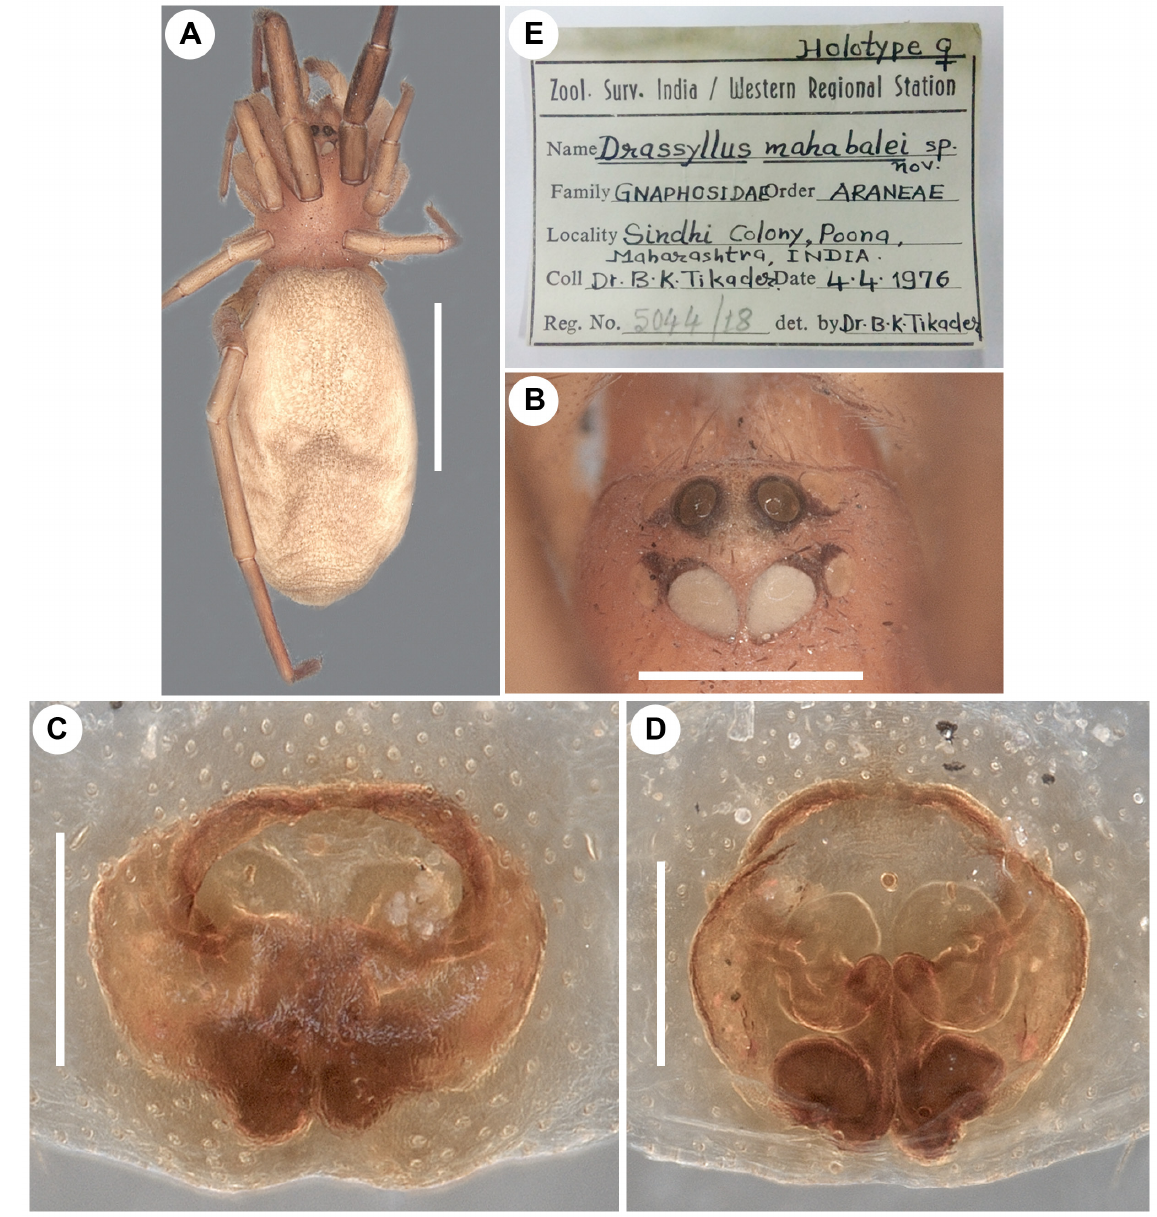
Fig. 3. Cryptodrassus mahabalei (Tikader, 1982) comb. nov., ♀, holotype of Drassyllus mahabalei Tikader, 1982 (NZC-ZSI-5044/18). A . Habitus, dorsal view. B . Eyes of the same, dorsal view. C . Epigyne, ventral view. D . Same, dorsal view. E . Label from type bottle. Scale bars: A = 2 mm; B = 0.5 mm; C–D = 0.2